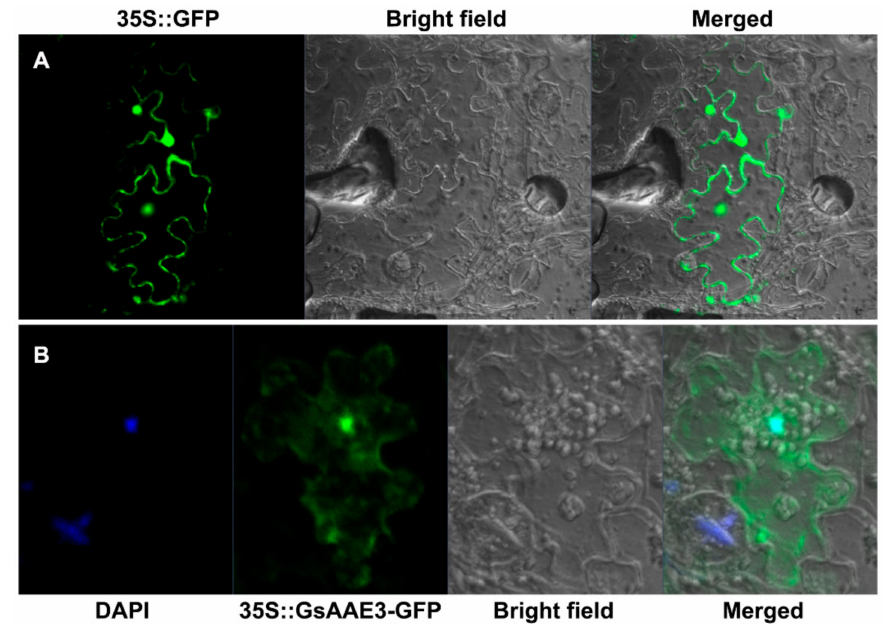
Figure 5. Subcellular localization of GsAAE3. ( A , B ) Green fluorescent protein (GFP) fluorescence images of tobacco leaves lower epidermal cells transiently expressing 35S::GFP and 35S::GsAAE3-GFP. DAPI (4 (cid:48) , 6-Diamidino-2-Phenylindole), a cell nucleus-specific fluorescence dye, was used to stain cell